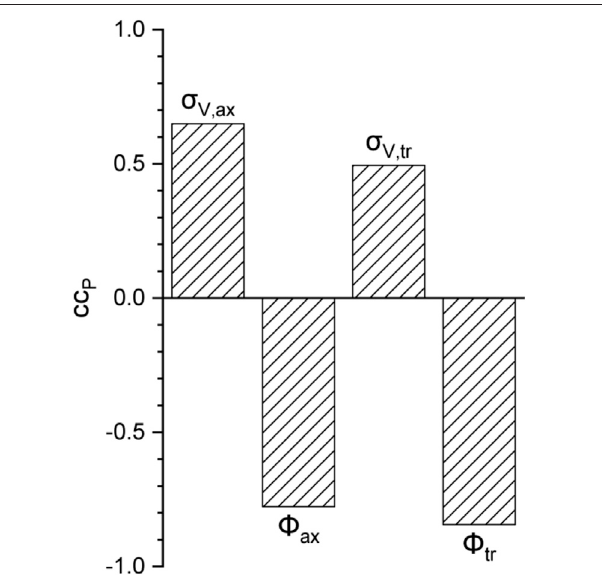
FIGURE 17 | Pearson correlation coef fi cient for σ V and fi ber volume